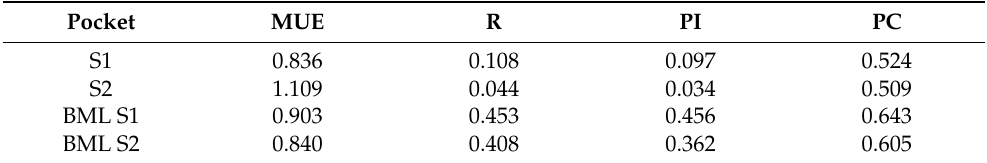
Table 1. Statistical analysis for SILCS models developed based on the 163 hERG1 blockers in the S1 and S2 binding pockets with and without BML